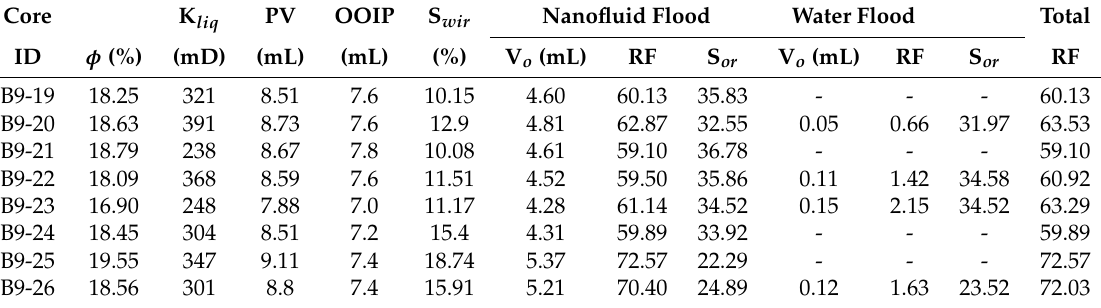
Table A1. Petrophysical properties of neutral-wet cores used for secondary nanofluid flooding experiments. The S wir and OOIP were established by centrifuge. The porosity and permeability were determined by helium porosimeter and gas permeameter,